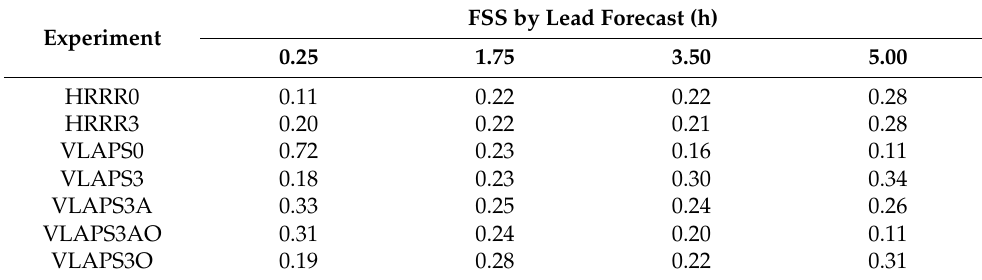
Table 3. FSS for 35 dBZ threshold and 9 km neighborhood size, at four different lead forecast times (h).